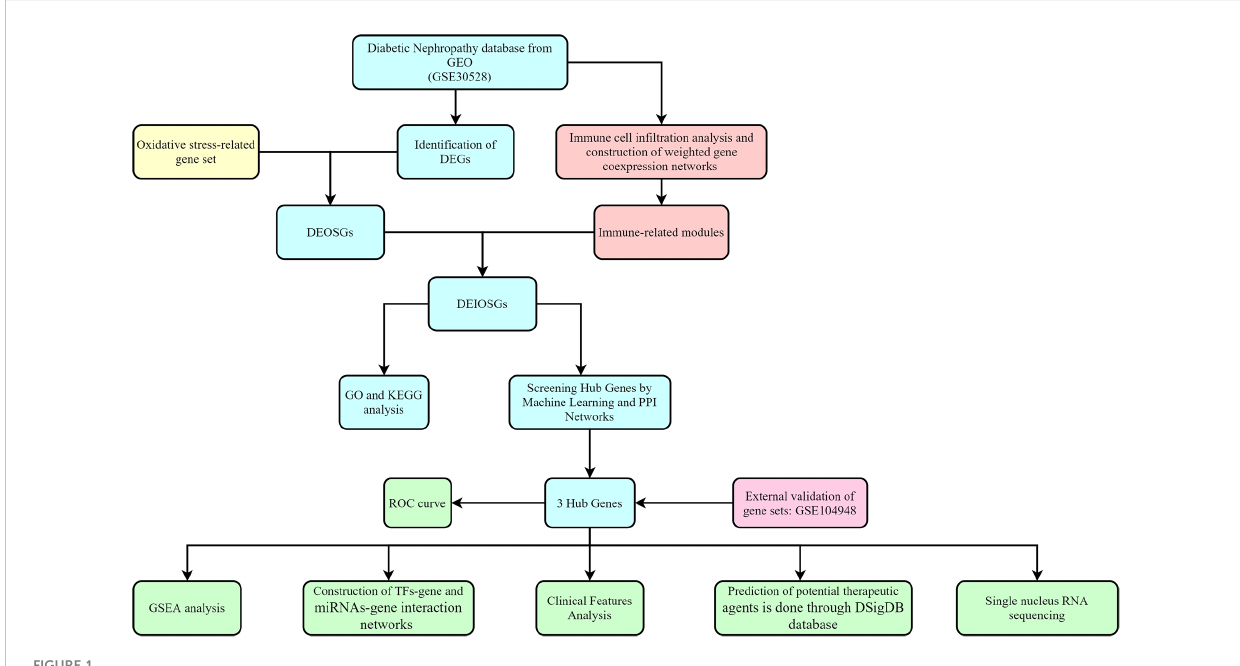
FIGURE 1 Flowchart for